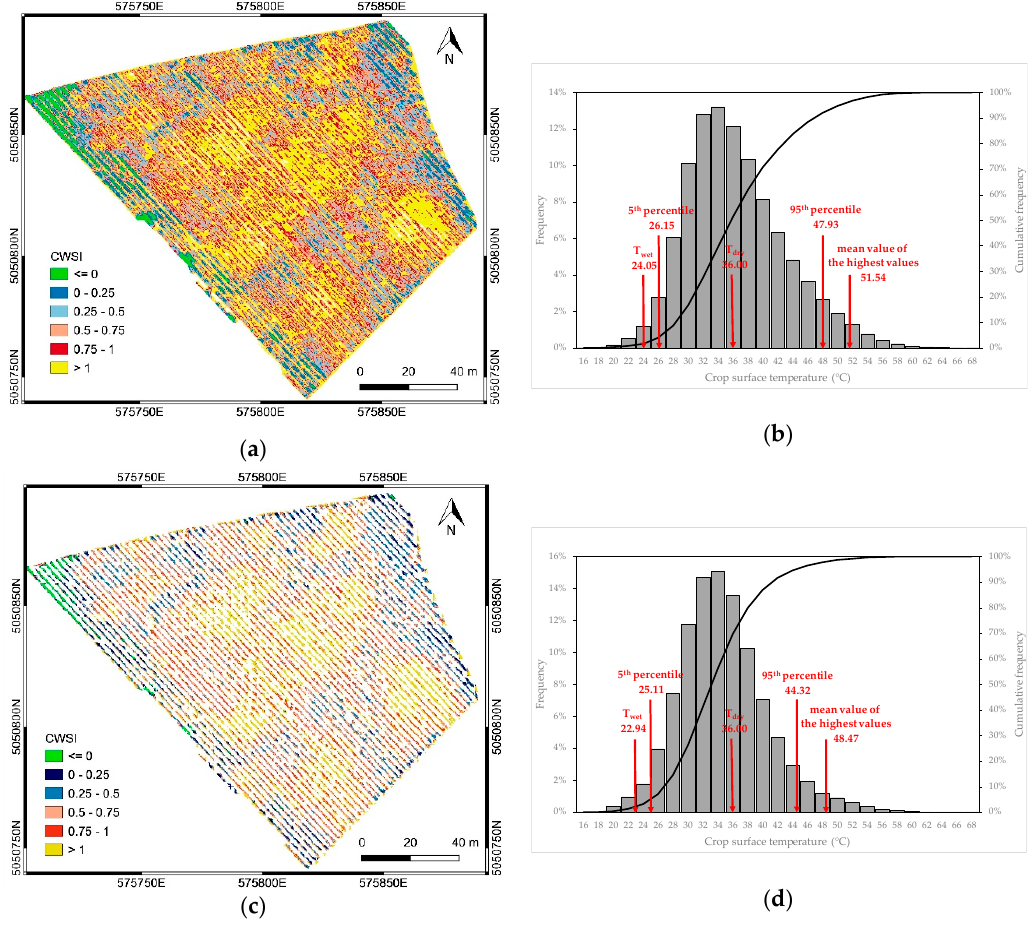
Figure 9. CWSI map before ( a ) and after ( c ) soil masking. The frequency distribution of the crop surface temperatures, with the illustration of T wet and T dry values calculated according to the empirical approach described in par. 3.1.3, is reported for each case ( b , d ).